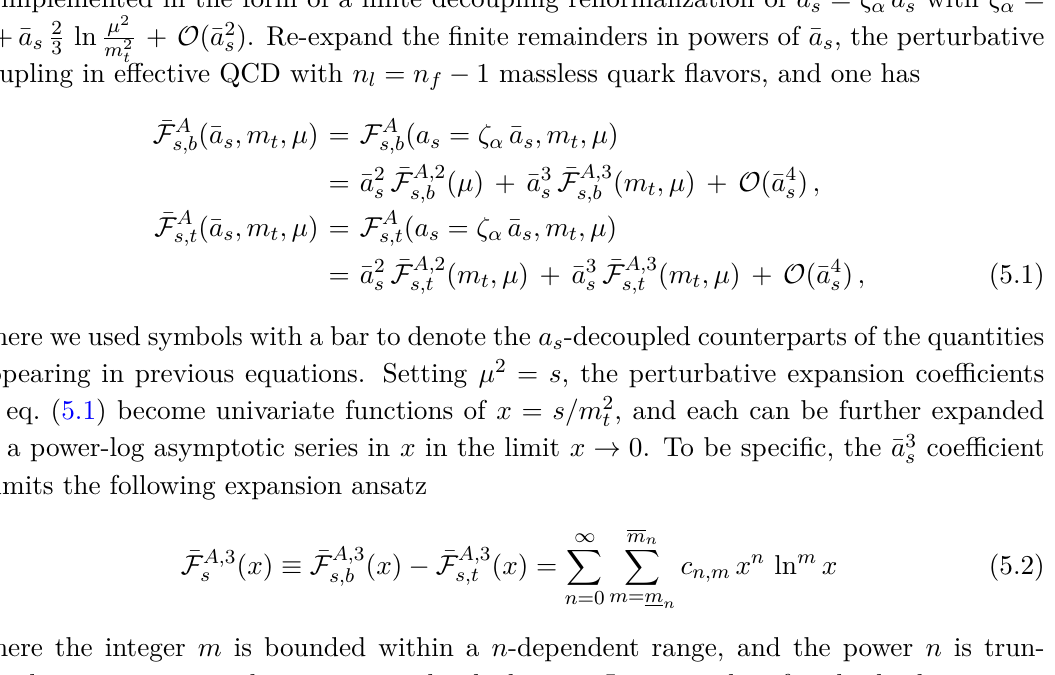
Figure 4 . The exact result for F V, 3 massless result C v ≡ F V, 3